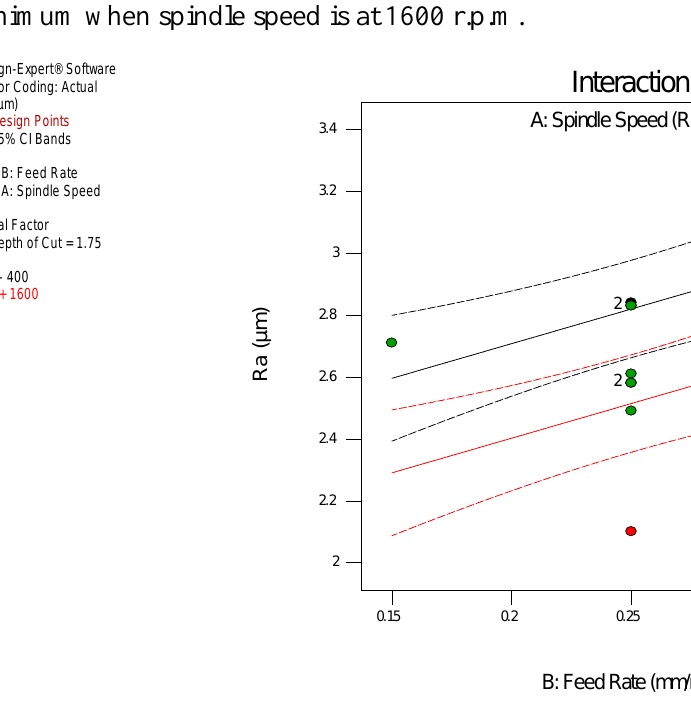
Fig. 9. Interaction plot for Ra vs Feed rate and spindle speed